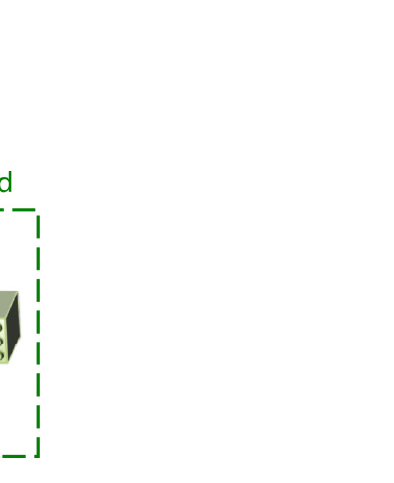
Figure 7. Network structure of Models 1–4.